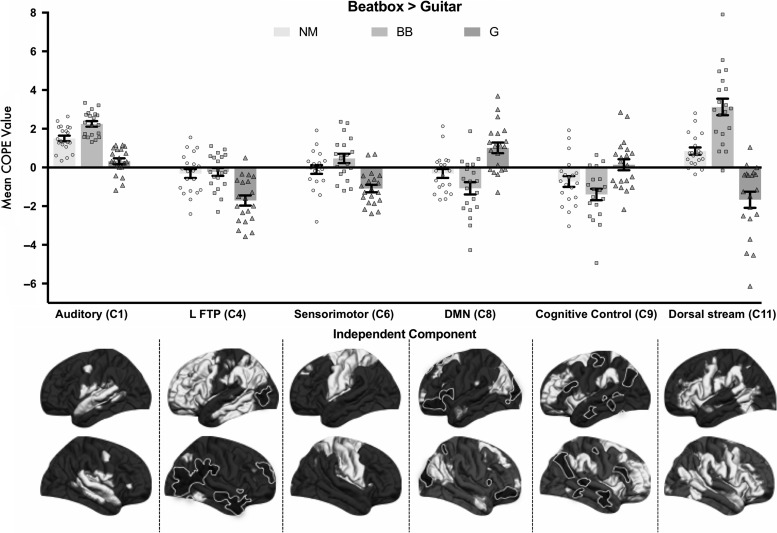
Demonstrates group × condition interactions in 6 of the 12 non-noise independent components derived using FSL MELODIC. The insets below each network label show regions included in the network, with regions that are positively covarying in white and those that show negative covariation in black. These are projected on the fsaverage cortical surface (for further details, such as activity on the medial surface, see Supplementary Fig. S1). Dual regression was used to derive subject-specific time courses for each of these 6 networks, and cope values for each network in each participant were calculated for the contrast beatbox > guitar music. In these graphs, values greater than 0 represent a preference for beatboxing relative to guitar music, whereas values less than 0 depict the opposite preference. Mean cope values for each group are shown by the bars, and the data points represent individual participants. Error bars depict ±1 SEM. Nonmusicians (NM) are depicted using filled circles, beatboxers (BB) with filled squares, and guitarists (G) using filled triangles. Musicians recruit auditory and sensorimotor networks as they listen to music they can produce, while inhibiting spatially overlapping default mode network (DMN) and executive control networks.